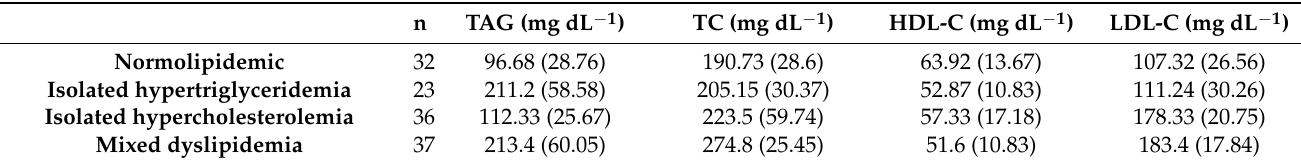
Table 1. Clinical classification of subjects according to their biochemical lipid profile. Data are shown as mean (standard